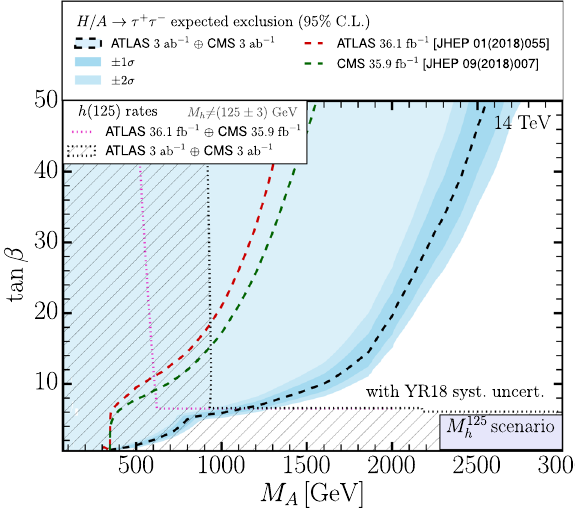
( ˜ χ) scenario with the same Fig. 2 HL-LHC projections in the M 125 Fig. 3 HL-LHC projections in the M 125 scenario, assuming YR18 h h systematic uncertainties (scenario S2 in Ref. [15]). The dashed black color coding as in Fig.2 curve and blue filled region indicate the expected HL-LHC reach via direct heavy Higgs searches in the τ + τ − channel with 6 ab − 1 of data (withthedarkblueregionsindicatingthe1and2 σ uncertainty),whereas the red and green dashed lines show the expected limit from current searches in this channel by ATLAS [109] and CMS [68], respectively. The current and future HL-LHC sensitivity via combined ATLAS and CMS Higgs rate measurements is shown as magenta and black dotted contours, respectively (the latter being accompanied with a hatching of the prospectively excluded region)